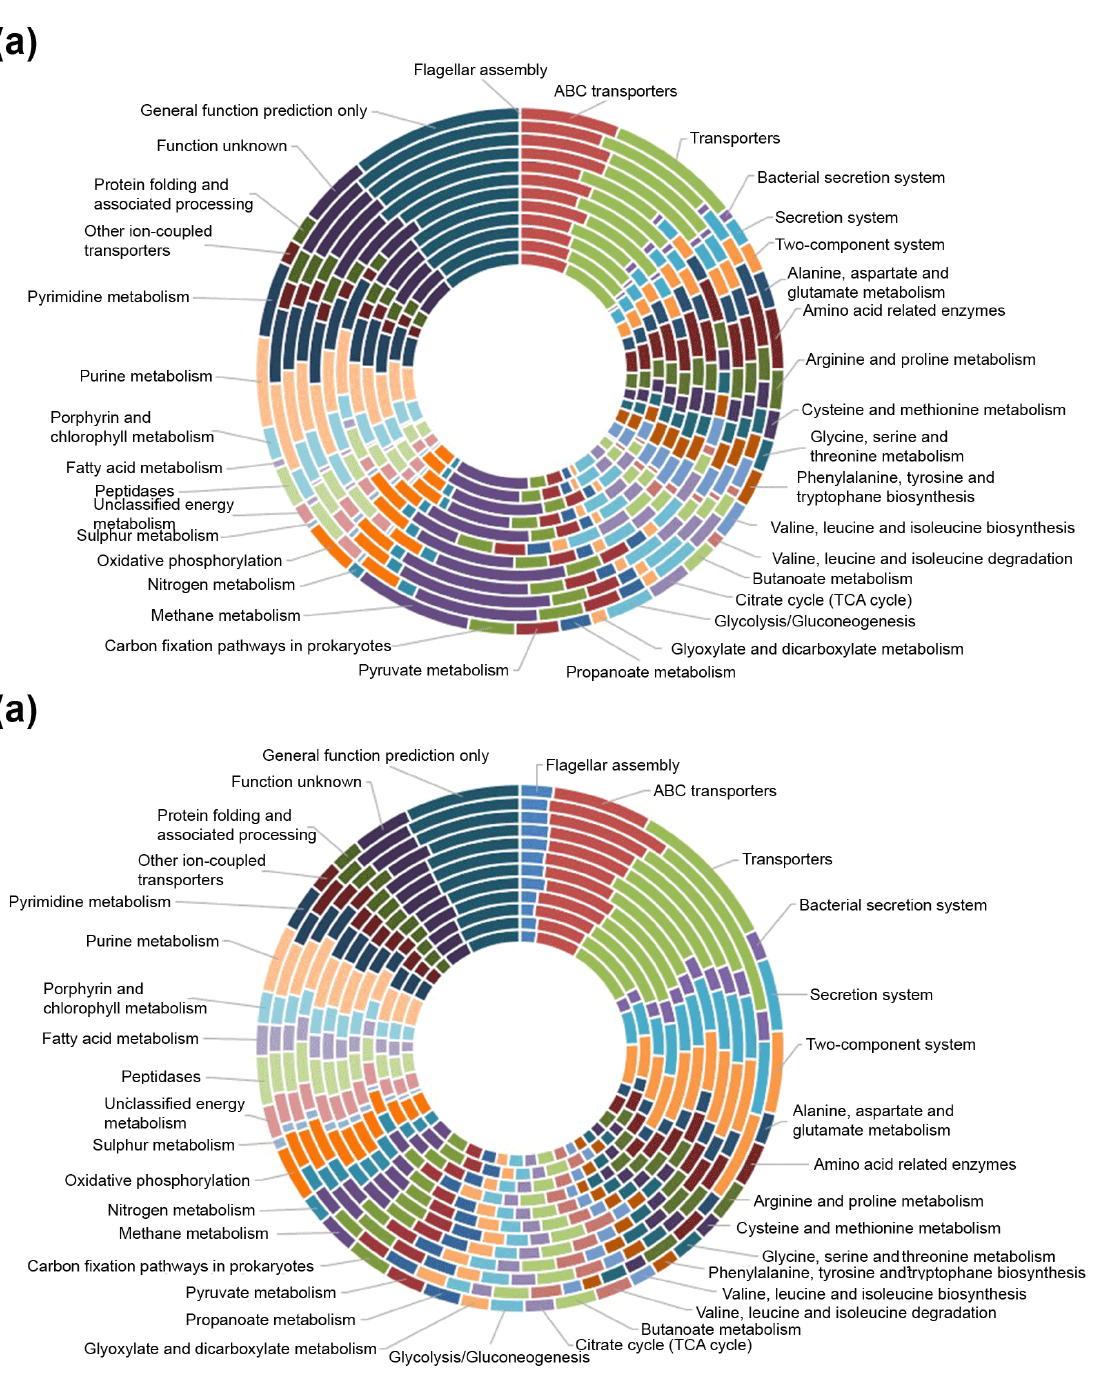
Figure 7. The relative abundance of predicted genes of the most abundant pathways identified in the (a) archaeal and (b) bacterial populations in the PICRUSt analysis. The pathways are presented according to KEGG. The samples are ordered according to depth, with OL-KR13/296m as the innermost sample and OL-KR29/798m as the outermost